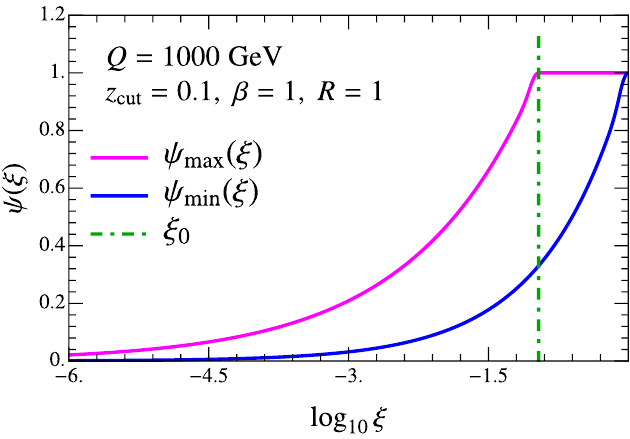
Figure 3 . The range of values of allowed ψ values as a function of ξ are shown by the region between the solid (magenta and blue) lines. The dot-dashed (green) line indicates where the transition to the ungroomed regime takes place. The maximum value of ψ corresponds to R g = θ ? in the ungroomed